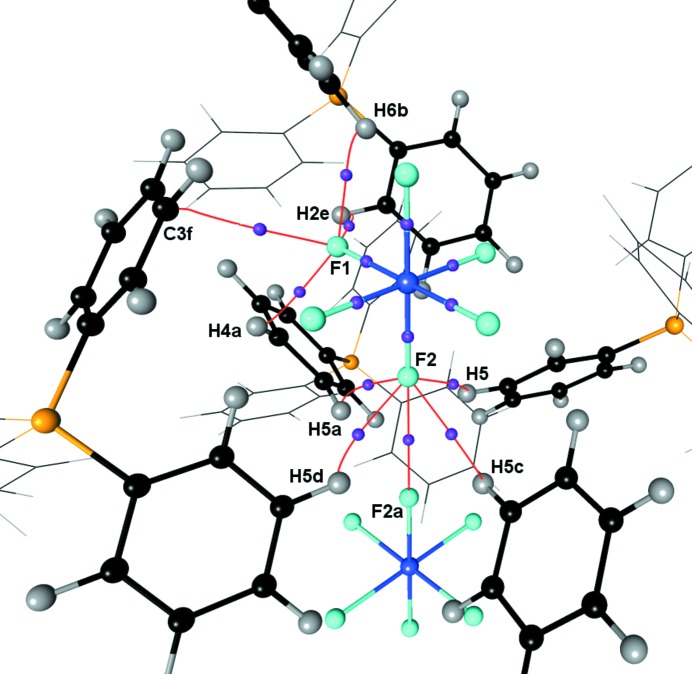
Molecular graph depicting intermolecular interactions around the independent fluorine atoms, only (3, −1) critical points are shown for clarity. F: light blue; U: blue; C: black; P: orange; H: gray; (3, −1) critical points: purple. Symmetry operators: a = y, 1 − x, 1 − z; b = y, 1 − x, −z; c = 1 − y, x, 1 − z; d = 1 − z, 1 − y, z; e = 0.5 − x, 1.5 − y, −0.5 + z; f = 1.5 − y, 0.5 + x, 0.5 − z.